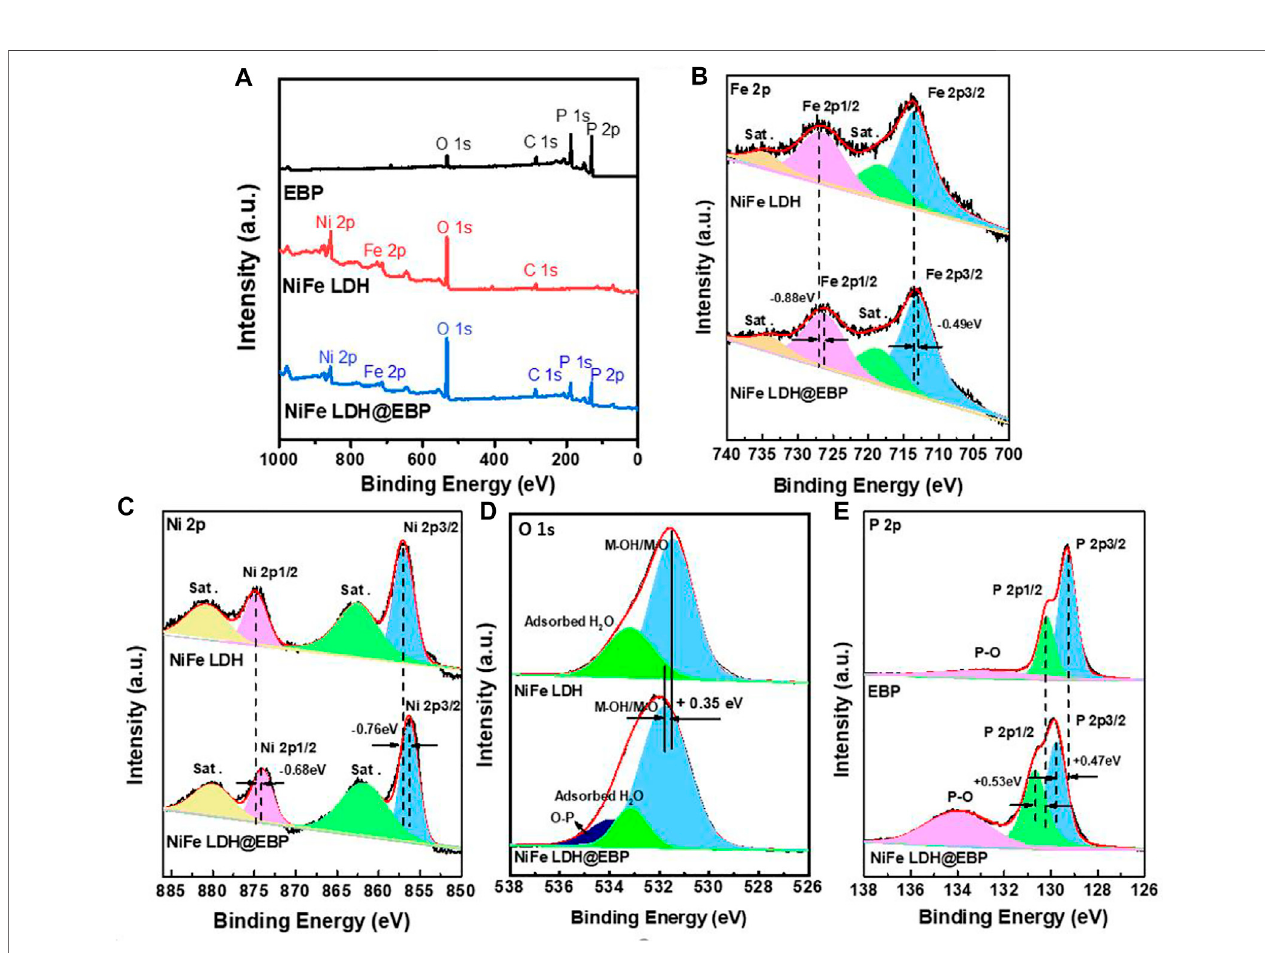
Frontiers in Chemistry |